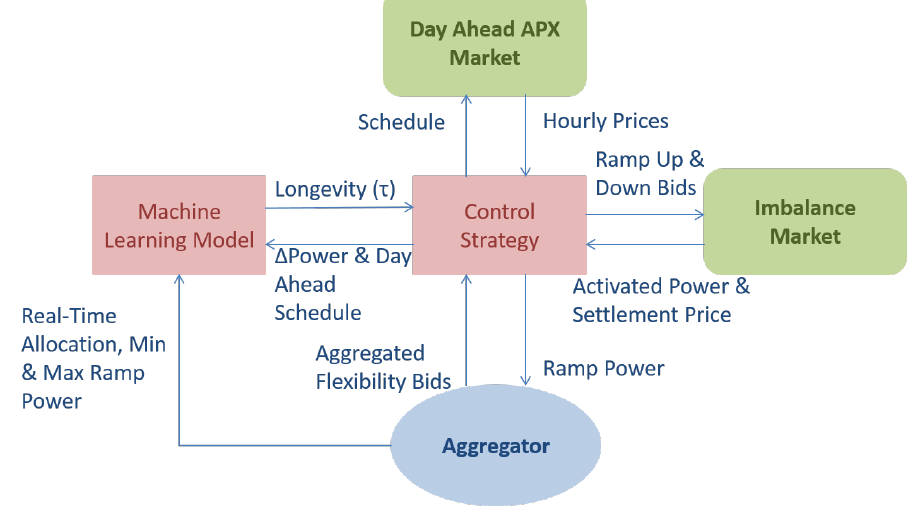
Figure 4. Information exchange between intelligence (red), electricity markets (green) and aggregator